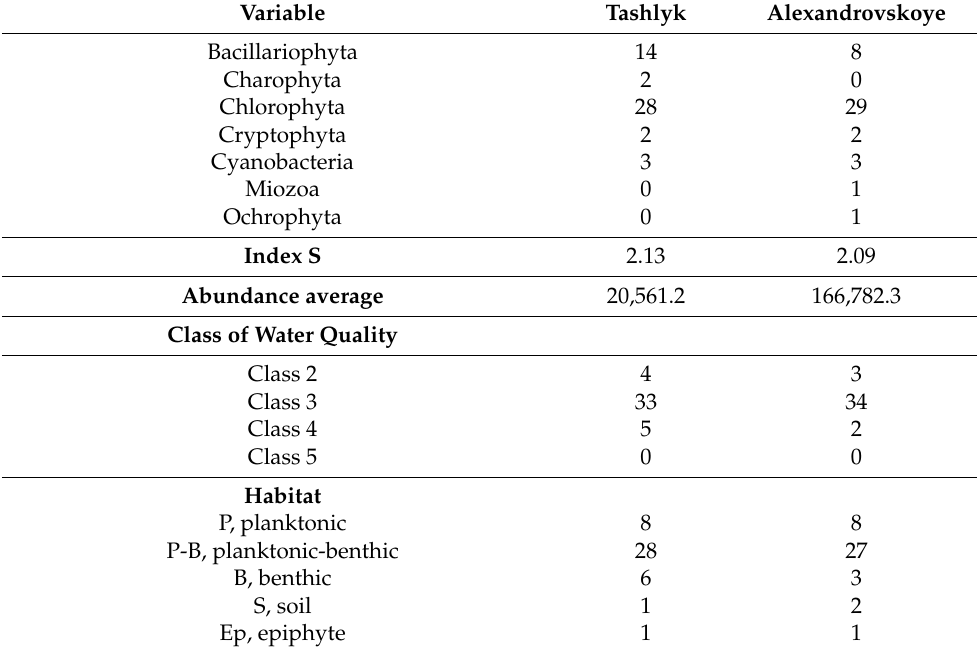
Table 3. Distribution of LITs in taxonomic phyla, average abundance of phytoplankton, indices of saprobity and the indicator species in the Tashlyk and Aleksandrovskoe reservoirs. Abbreviations of ecological groups are given at the end of Table 3 and in Table